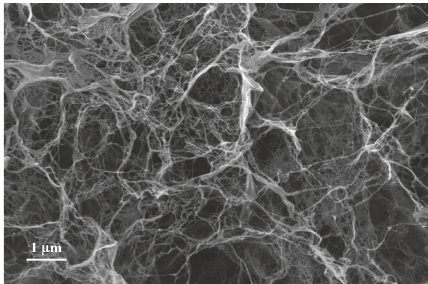
Table 1: Crystallinity of TPS/PVA cellulose nanocomposite